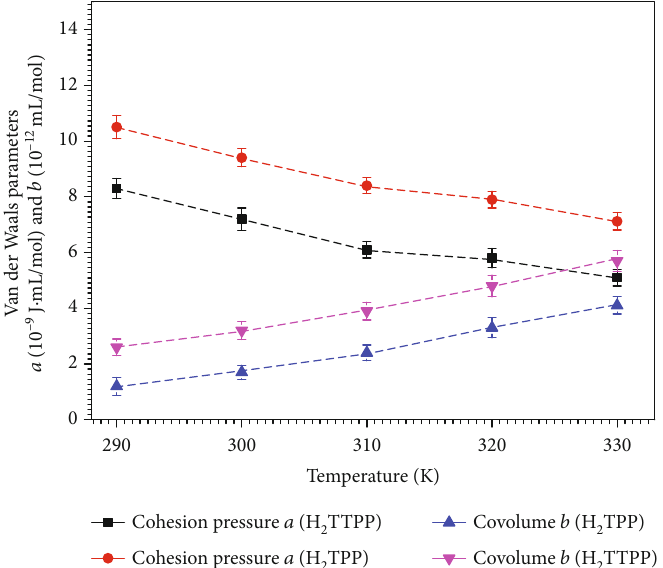
Figure 7: Variations of the adjusted values of the cohesion pressure a and the covolume b as a function of temperature (290-330K) for the indium chloride